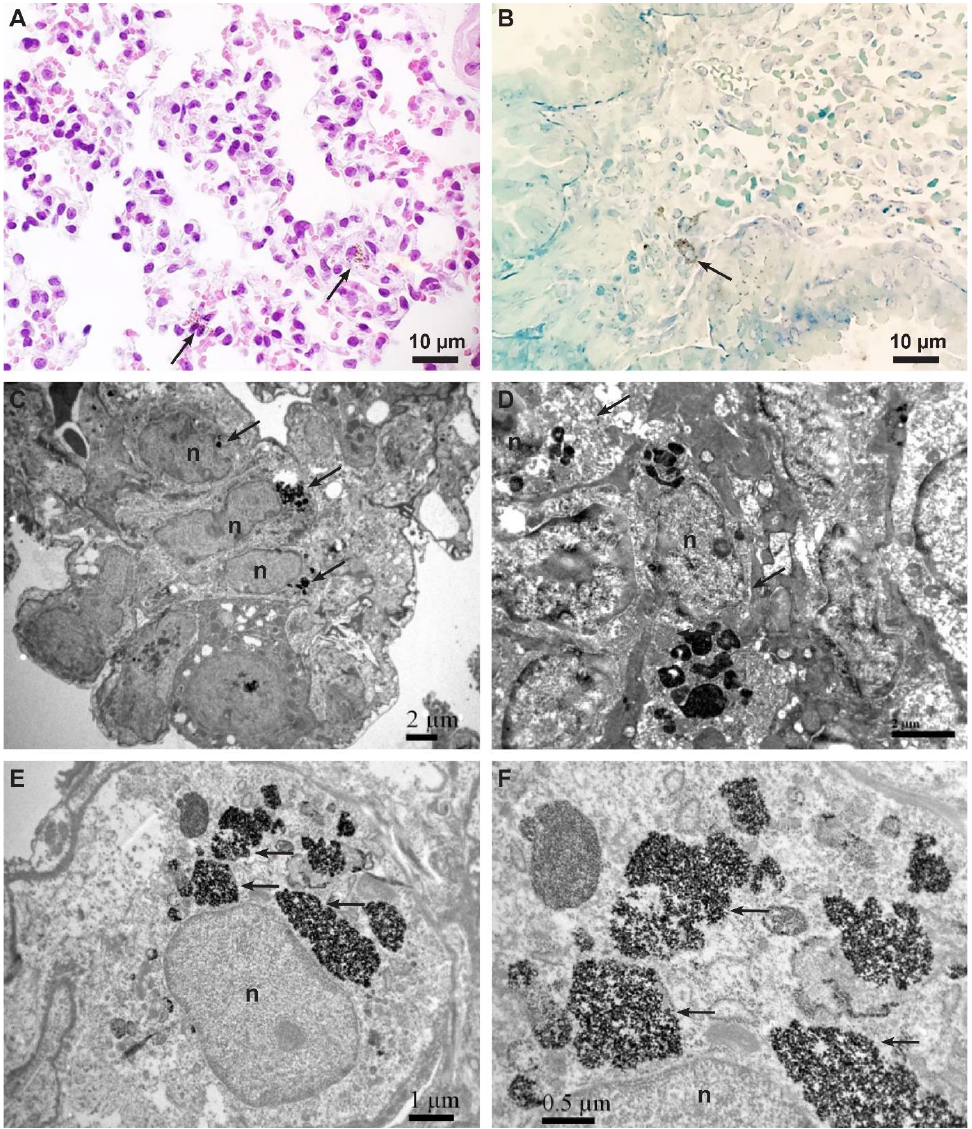
Figure 2. Representative micrographs of MSCs with internalized CoFe 2 O 4 . ( A ) Light micrograph of hematoxylin and eosin staining showing scattered cells containing brown particles inside the cyto- plasm (arrows). ( B ) Micrograph of a semi-thin section stained with Azure II. Note the cell full of brown particles inside the cytoplasm (arrow). ( C ) TEM micrograph of three MSCs (arrows) contain- ing electron-dense NPs in endosomes in the lungs of control mouse. Scale bar: 2 µm. ( D ) TEM mi- crograph of two MSCs (arrows) containing electron-dense NPs in endosomes in the spleen of cis- platin-treated mouse. Scale bar: 2 µm. ( E ) TEM micrograph of MSC containing electron-dense NPs in numerous endosomes (arrows) in the lungs of cisplatin−treated mouse. Scale bar: 1 µm. ( F ) Higher magnification of endosomes (from ( E ) ) fully loaded with electron−dense NPs (arrows). Scale bar: 0.5 µm. Legend: n−nucleus.